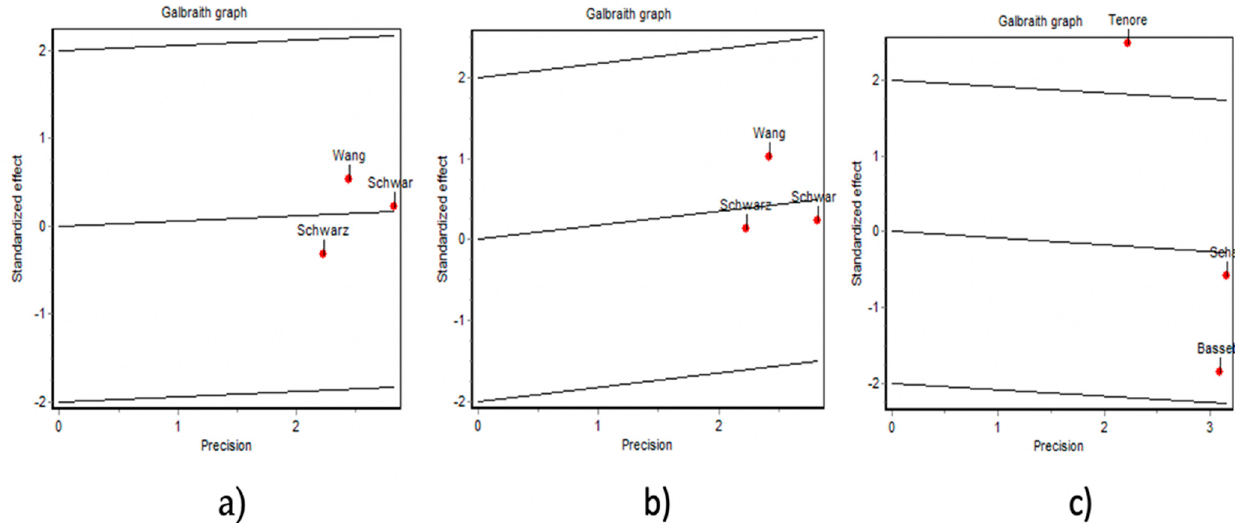
Figure 5. Galbraith graph to show the heterogeneity of the analyzed study: ( a ) CAL gain in Er:YAG laser group ( p = 0.7854), ( b ) PPD reduction in Er:YAG laser group ( p = 0.8364) and ( c ) PPD reduction in diode laser group ( p = 0.0075).